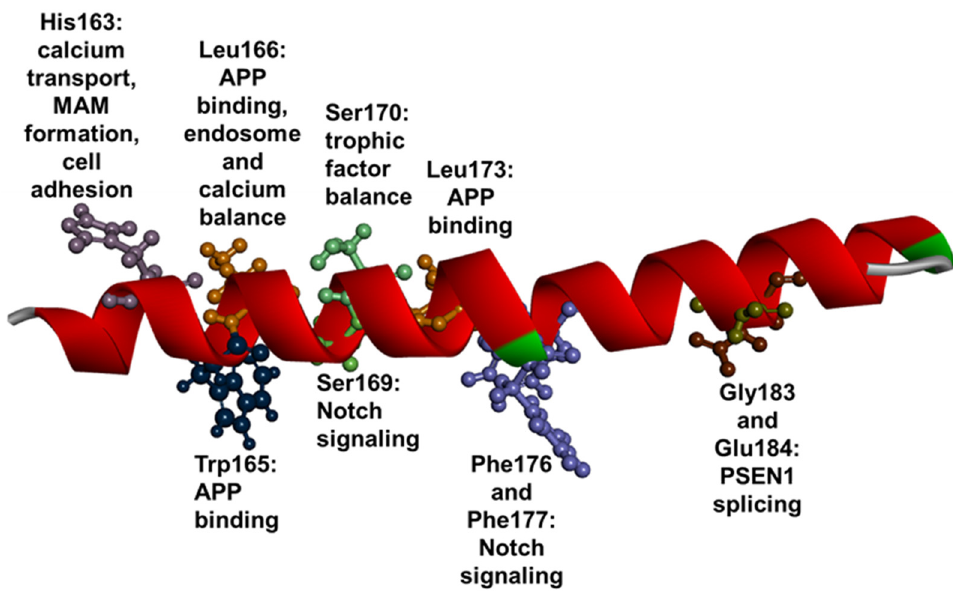
Figure 6. Significant residues in